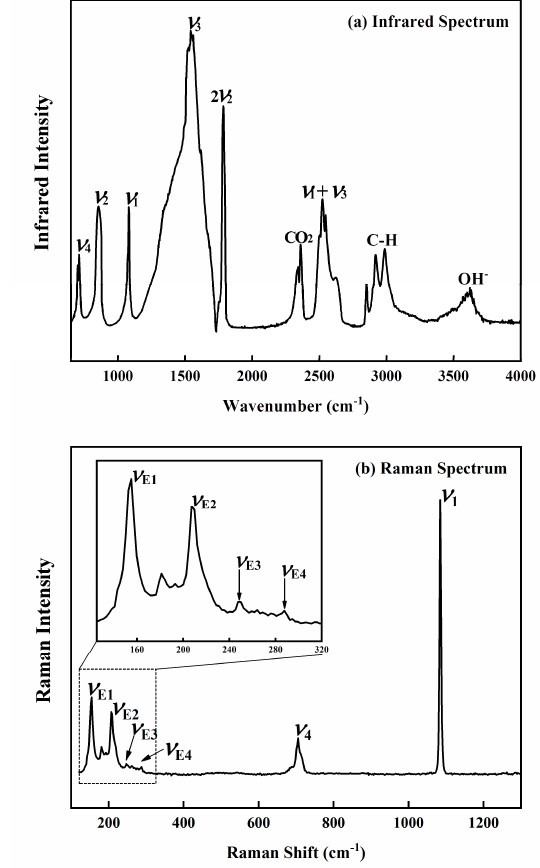
Figure 3. ( a ) Infrared and ( b ) Raman spectrum of aragonite at ambient conditions corrected for background effects.